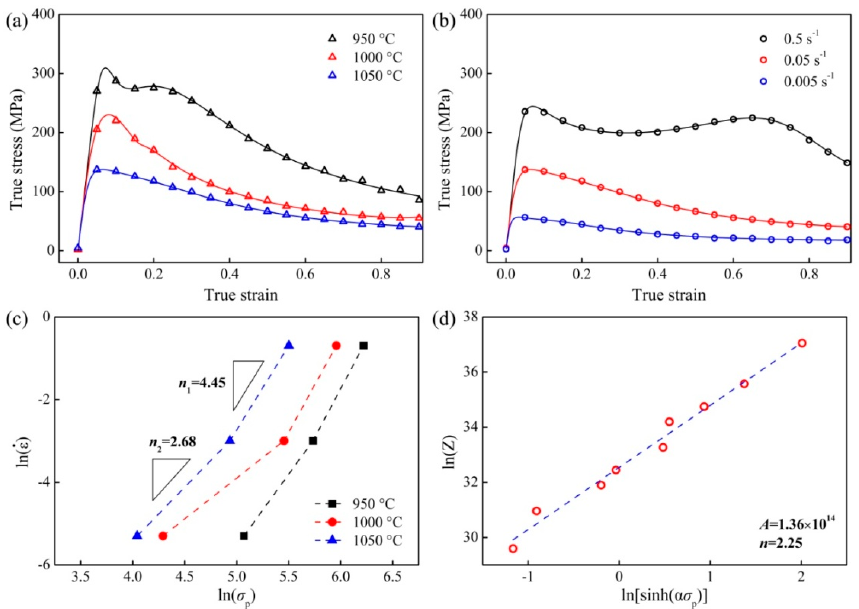
Figure 3. Flow curves at ( a ) 0.05 s − 1 and ( b ) 1050 °C for the present alloy; ( c ) Variation of the stress exponent with stress; ( d ) Linear relationship between Zener–Hollomon parameter and peak stress.